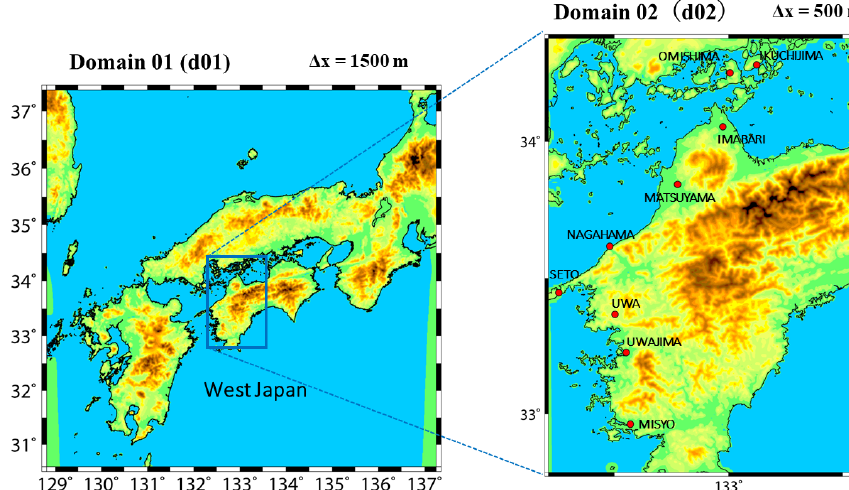
Figure 2. Calculation areas and geographies of coarse resolution (d01) and fine resolution (d02) domains.